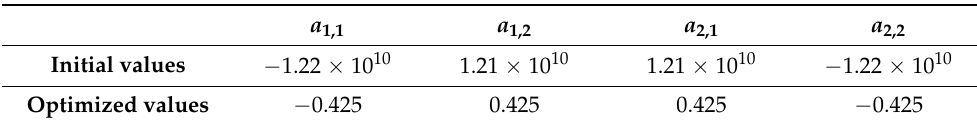
Table 2. Comparison of the initial and optimized values of parameters of the model in state-space representation, for wall_616